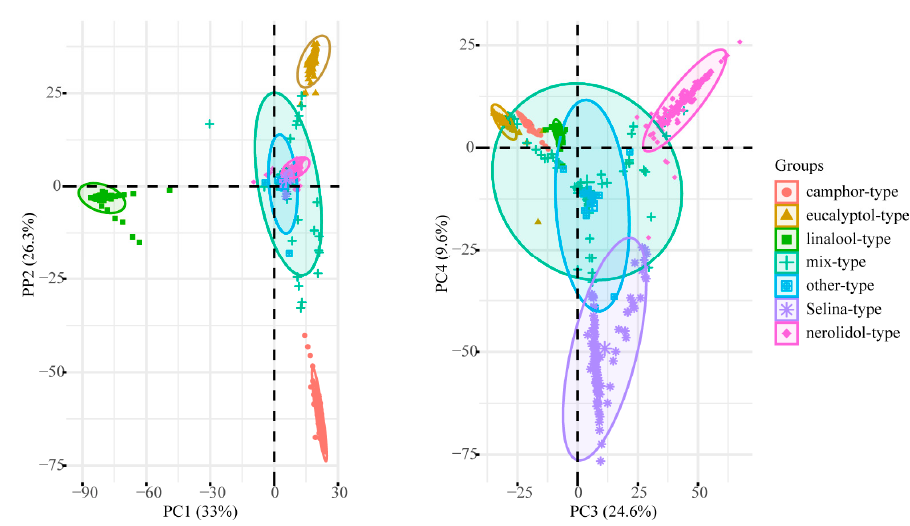
Molecules 2023 , 28 , x FOR PEER REVIEW Figure 3. Principal component analysis of the first four dimensions. Analysis of variance (ANOVA) revealed significant differences ( p < 0.01) in essential oil yield among the different chemotypes (Table 4). The yields for the eucalyptol and linalool types (1.64% and 1.55%, respectively) were significantly higher than those for the other five chemotypes (<1.00%), whereas the trans -nerolidol chemotype had the lowest yield (0.22%). Within each chemotype, the yields of essential oils showed significant variance. For the eucalyptol type, the highest yield (in the range of 0.09–3.28%) was 36 times higher than the lowest yield; 86 times higher for the camphor type, and 10 times higher for the linalool type. The extreme variability within chemotypes provided sufficient basis for selecting optimal wild individuals. One or two chemotypes were predominant in each population (Figure 4). The eucalyp- tol and linalool types were predominant in populations from Qimen, Xianning, Changde, Xinhua, Yongzhou, and Hanzhong; the nerolidol type was predominant in populations from Fuzhou, Shaoguan, Zhenjiang, Tonglu, and Yuyao; the selina type was predominant in populations from Huaan, Yongan, and Youxi; and the camphor type was predominant in populations from Gaofeng and Guiyang.